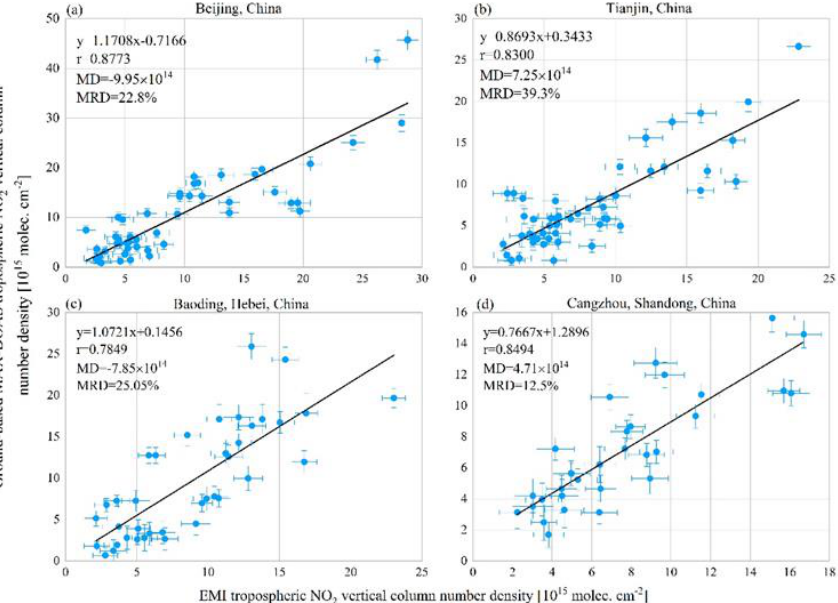
Figure 7. Scatter plot results for the comparison of tropospheric NO 2 VCDs from EMI and MAX-DOAS for November 2018 to April 2019: Beijing ( a ), Tianjin ( b ), Baoding ( c ), Cangzhou ( d ).